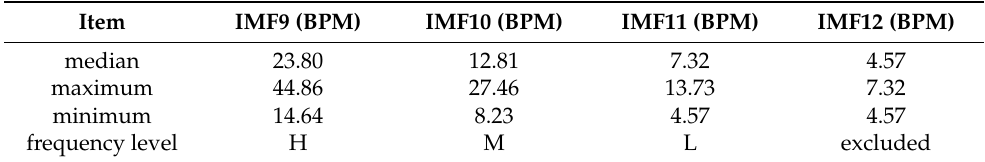
Table 2. The frequency distribution of